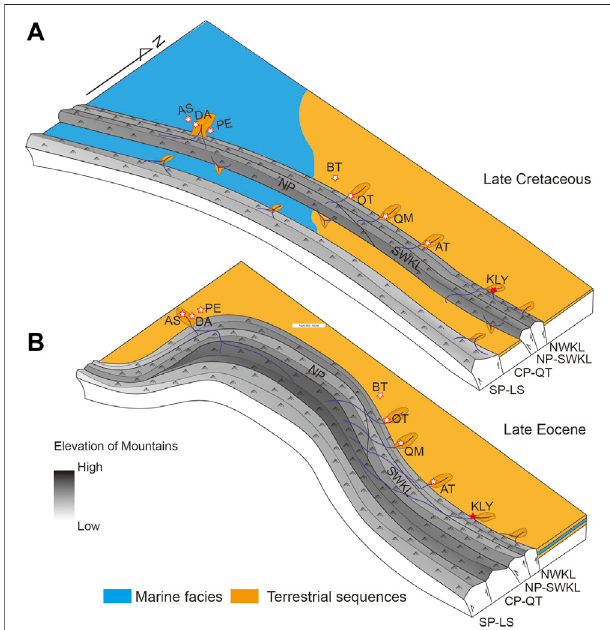
FIGURE 9 | Simpli fi ed tectonic evolution models of Pamir-West Kunlun. (A) During the Late Cretaceous, West Kunlun had a moderate paleo-elevation and was the main sediment source to the SW Tarim Basin. The Central Pamir region was occupied by shallow seas. (B) During the Late Eocene, the Central Pamir experienced rapid uplift and attained a higher paleo-elevation than that of the present-day West Kunlun, providing new sediments to the Tajik and Tarim basins. NWKL (cid:1) North West Kunlun; NP-SWKL (cid:1) North Pamir-Southern West Kunlun; CP-QT (cid:1) Central Pamir-Qiang Tang; SP-LS (cid:1) South Pamir - Lhasa; DA (cid:1) Dashtijum section; AS (cid:1) Asku section; PE (cid:1) Peshtova section; BT (cid:1) Bora Tokay section; OT (cid:1) Oytag section; QM (cid:1) Qimugen section; AT (cid:1) Aertashi section; KY (cid:1) Keliyang section.